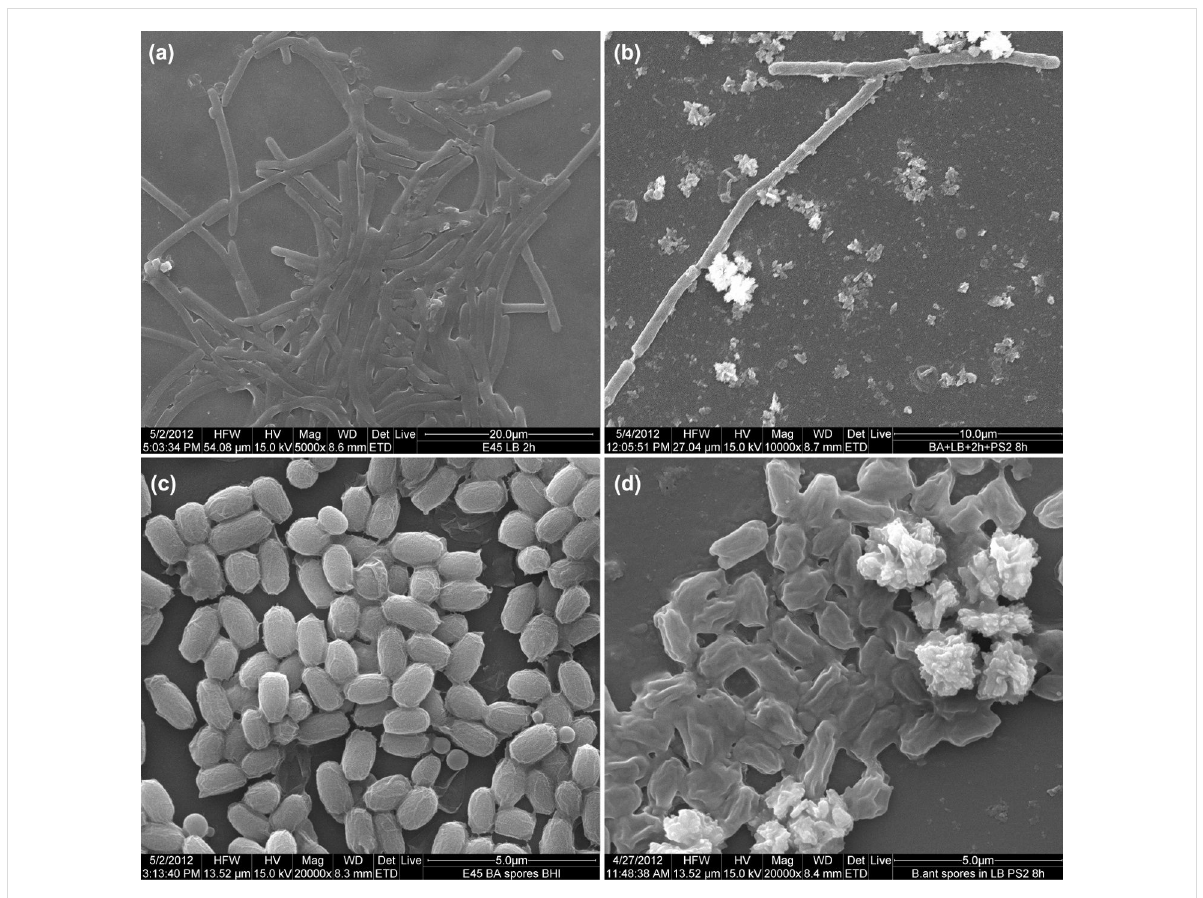
Figure 8: SEM micrographs of B. anthracis spores. a) After 2 h of incubation in LB broth, 5000×. b) After 2 h of incubation in LB broth then PS2 addi- tion and 8 h of incubation overall, 10000×. c) Control untreated spores, 20000×. d) Spores in LB broth plus PS2 after 8 h of incubation, 20000×.